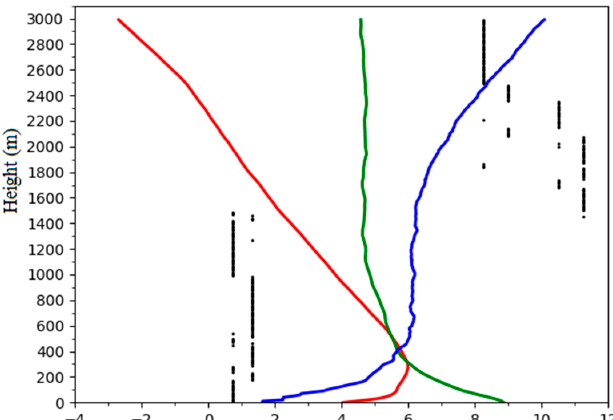
Figure 7. Averaged vertical structure of the atmosphere for 360 days. The line and scatter plot show the profile of detected temperature (red line, °C), relative humidity (green line, %),wind velocity (blue line, m/s) and wind direction (black scatter points, wind direction is the dominant wind direction at each height, °). The number on the x-axis is the result after dividing the relative humidity value by 10 and wind direction angle by 30 while temperature and wind speed remain the same.